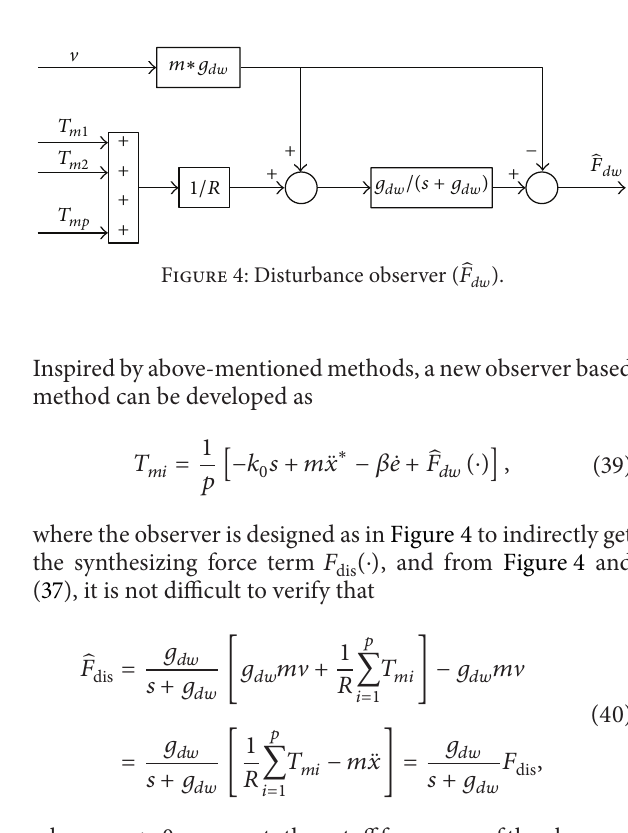
Figure 4: Disturbance observer (